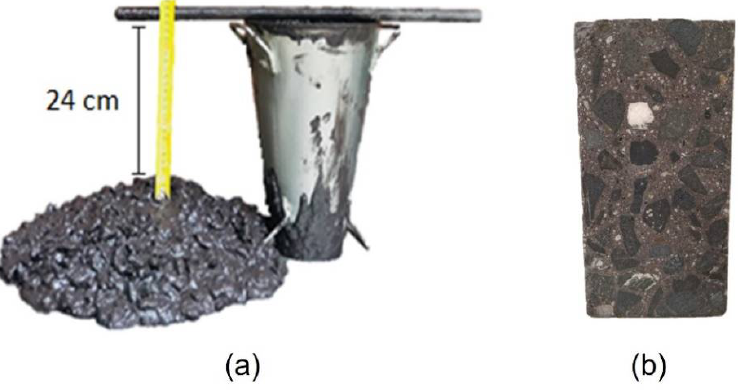
Figure 10. (a) Slump test; and (b) internal appearance of aggregates distribution in the hybrid concrete